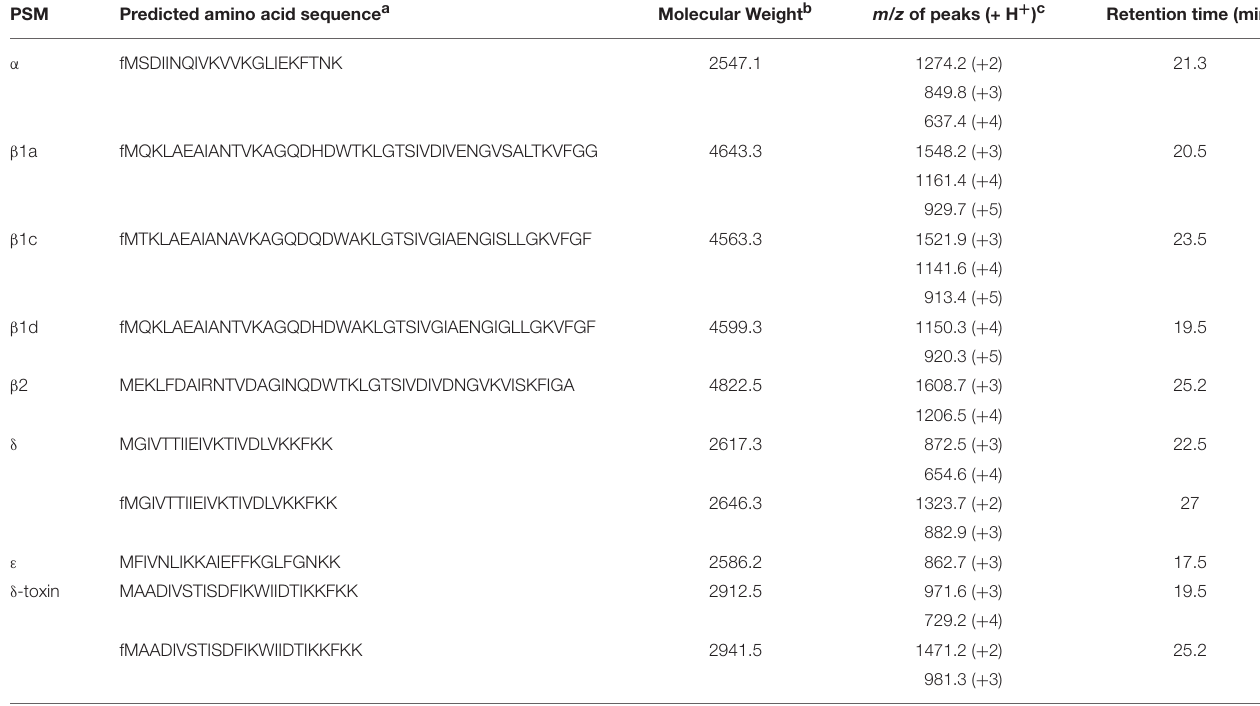
TABLE 4 | Predicted PSMs of S. capitis strain AYP1020 were detected in the culture supernatant using HPLC followed by mass spectrometry. PSM Predicted amino acid sequence a Molecular Weight b m / z of peaks (+ H + )